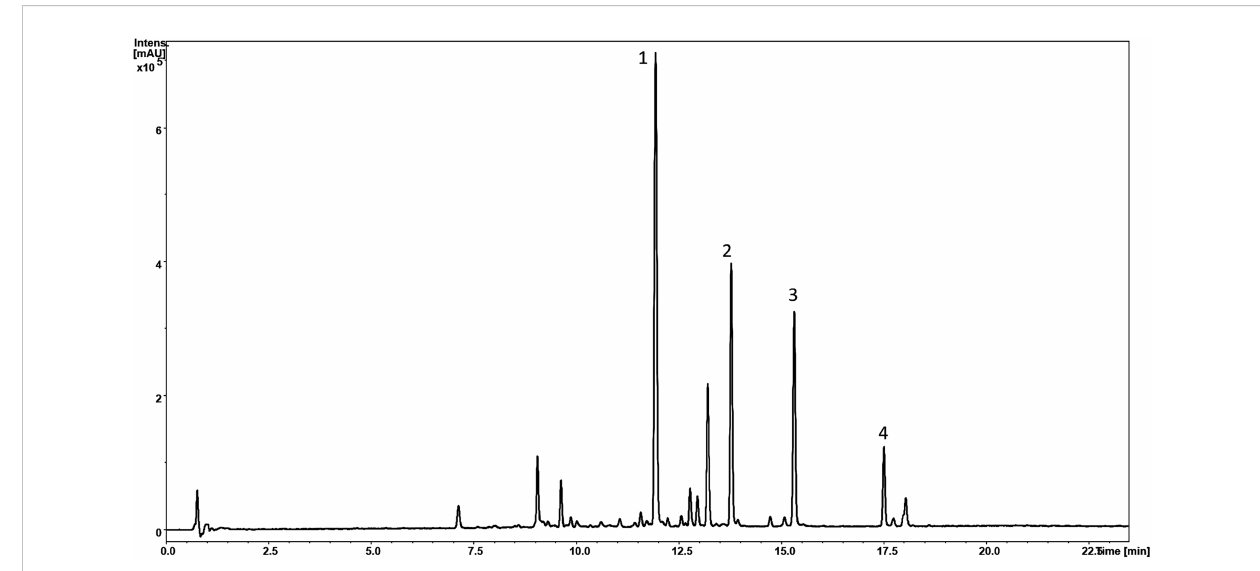
FIGURE 6 HPLC-MS chromatogram (UV 280 nm) of S. baicalensis root methanolic extract (Control) with marked peaks corresponding to baicalin (1), wogonoside (2), baicalein (3), and wogonin (4)